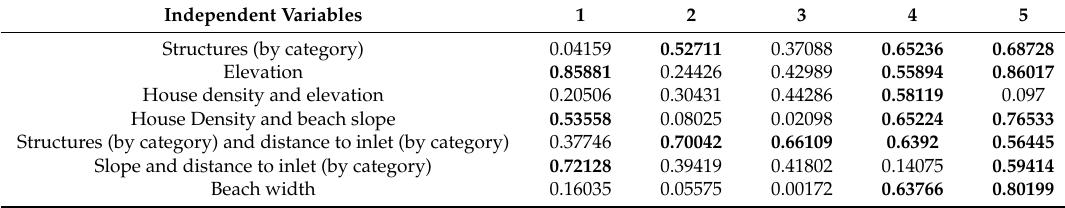
Table 4. R-squared values using Geographically Weighted Regression models for each region 1 . R-squared values > 0.5 were considered significant (in